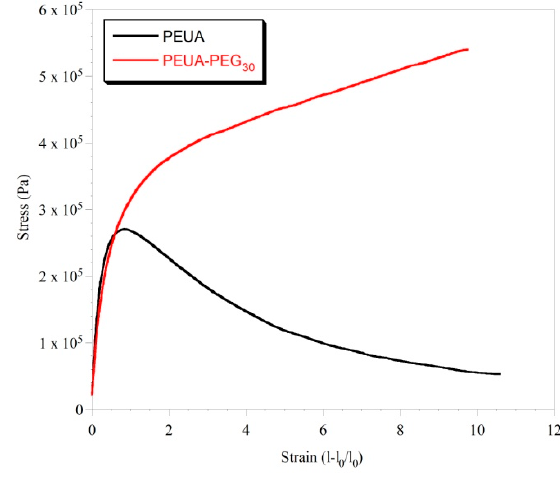
Figure 8. Stress-strain curves of PEUA and PEUA-PEG 30 . Figure 8. Stress ‐ strain curves of PEUA and PEUA ‐ PEG 30 .